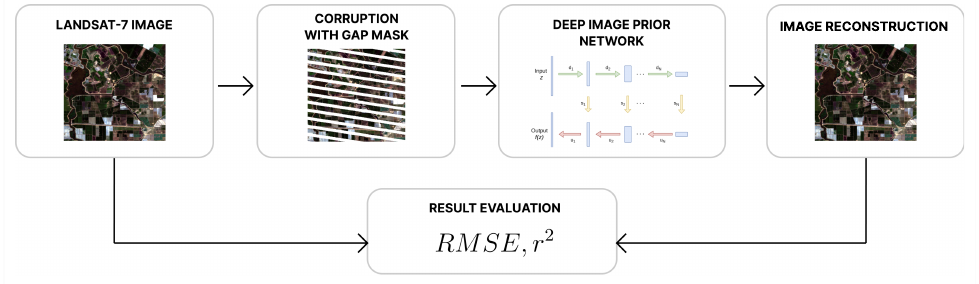
Figure 1. Outlines of the